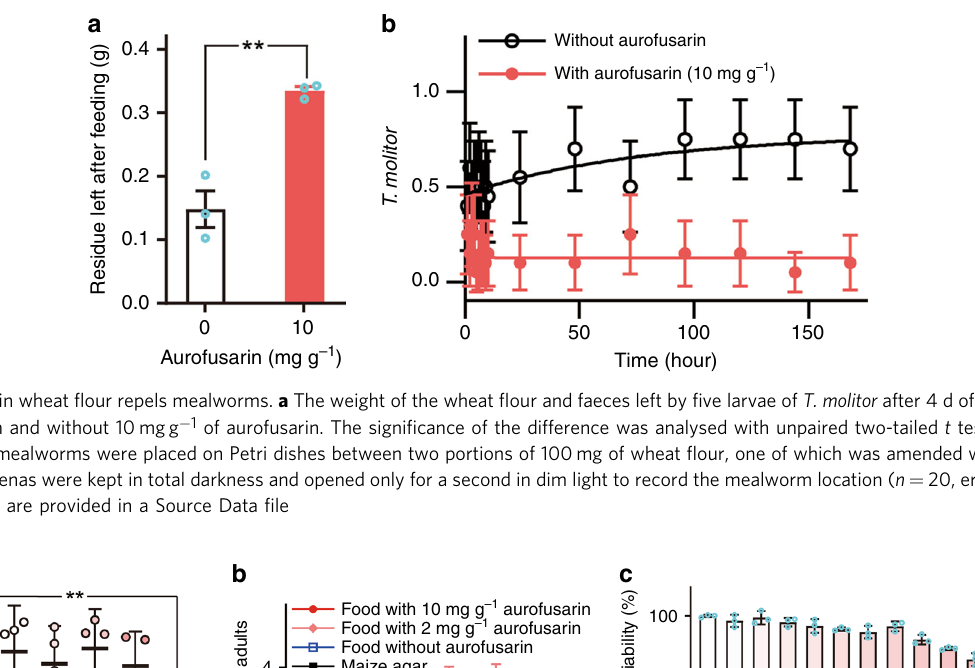
Table 1 Growth of predators fed aurofusarin mutants of Fusarium graminearum Predator F. g .